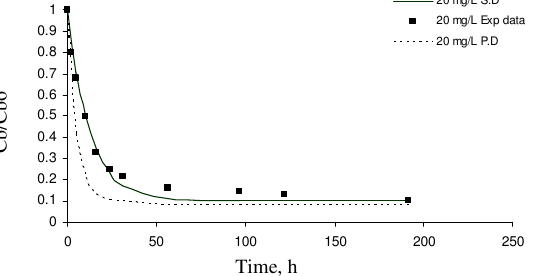
Figure 1(a). Comparison between prediction of film-surface diffusion (S.D) and film-pore diffusion (P.D) models with experiments data from adsorption of RB 5 onto PKS-based activated carbon at dye concentration of 20 mg/L and dosage of adsorbent 2 g/L (single system).